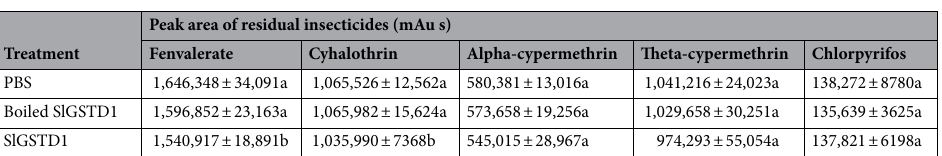
Table 1. The metabolism activity of purified recombinant SlGSTD1 to insecticides. Different lowercase letters indicated significant differences analyzed by the student’s test ( P < 0.05).